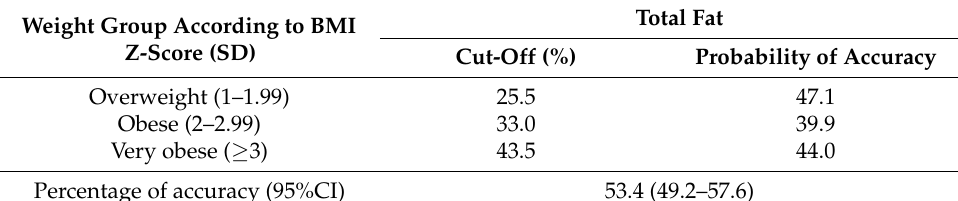
Total Fat Cut-Off (%) Probability of Accuracy